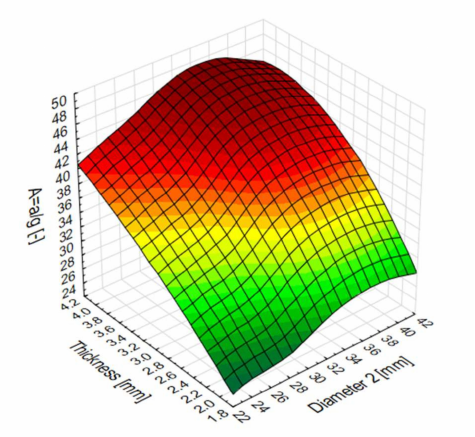
Figure 15. The g-load multiple (A) surface plot for numerical models.